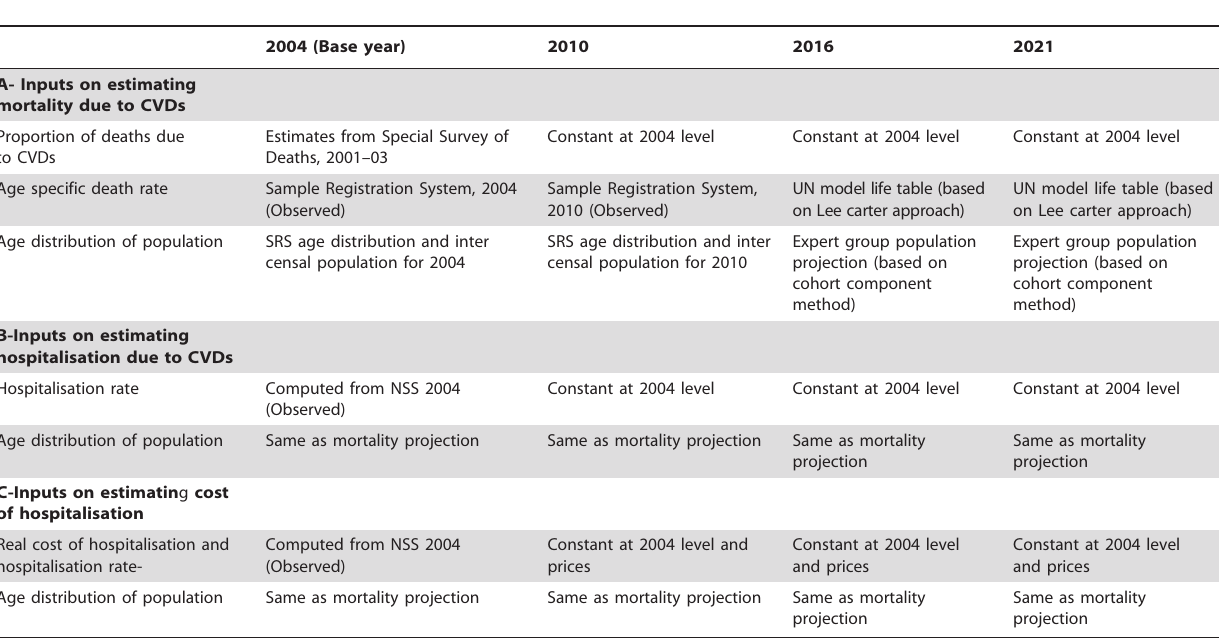
Table 1. Assumptions on projecting deaths, hospitalisation and cost of hospitalisation for cardiovascular diseases, India, 2004–21.